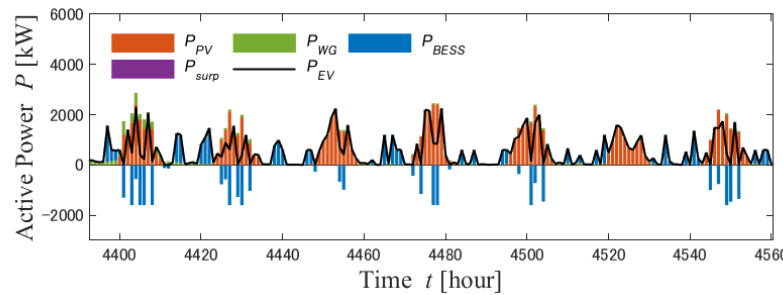
Figure 22. Generated power and load from July 1 to 7 (Case 2).